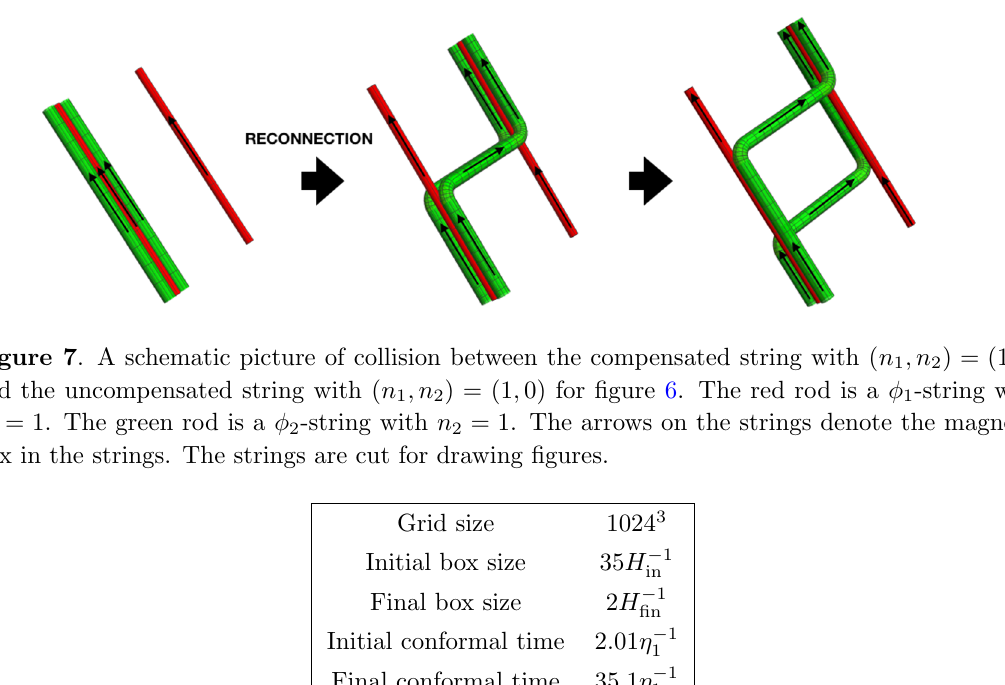
Figure 6 . Collision between the compensated string with ( n 1 ; n 2 ) = (1 ; 2) and the uncompensated string with ( n 1 ; n 2 ) = (1 ; 0) at late times. The notation is the same as (cid:12)gure 2.